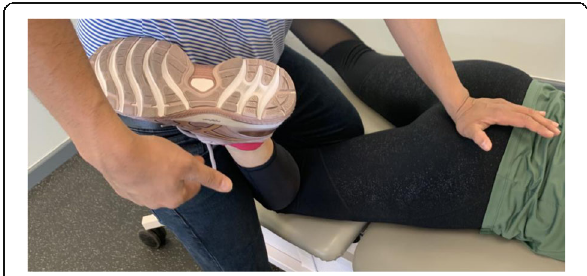
Fig. 2 Muscle energy technique. Unilateral sacral flexion. Patient position prone. Resisted internal rotation of the hip. Manual force to the inferior lateral angle applied antero-superiorly by the therapist. Picture taken with verbal and written